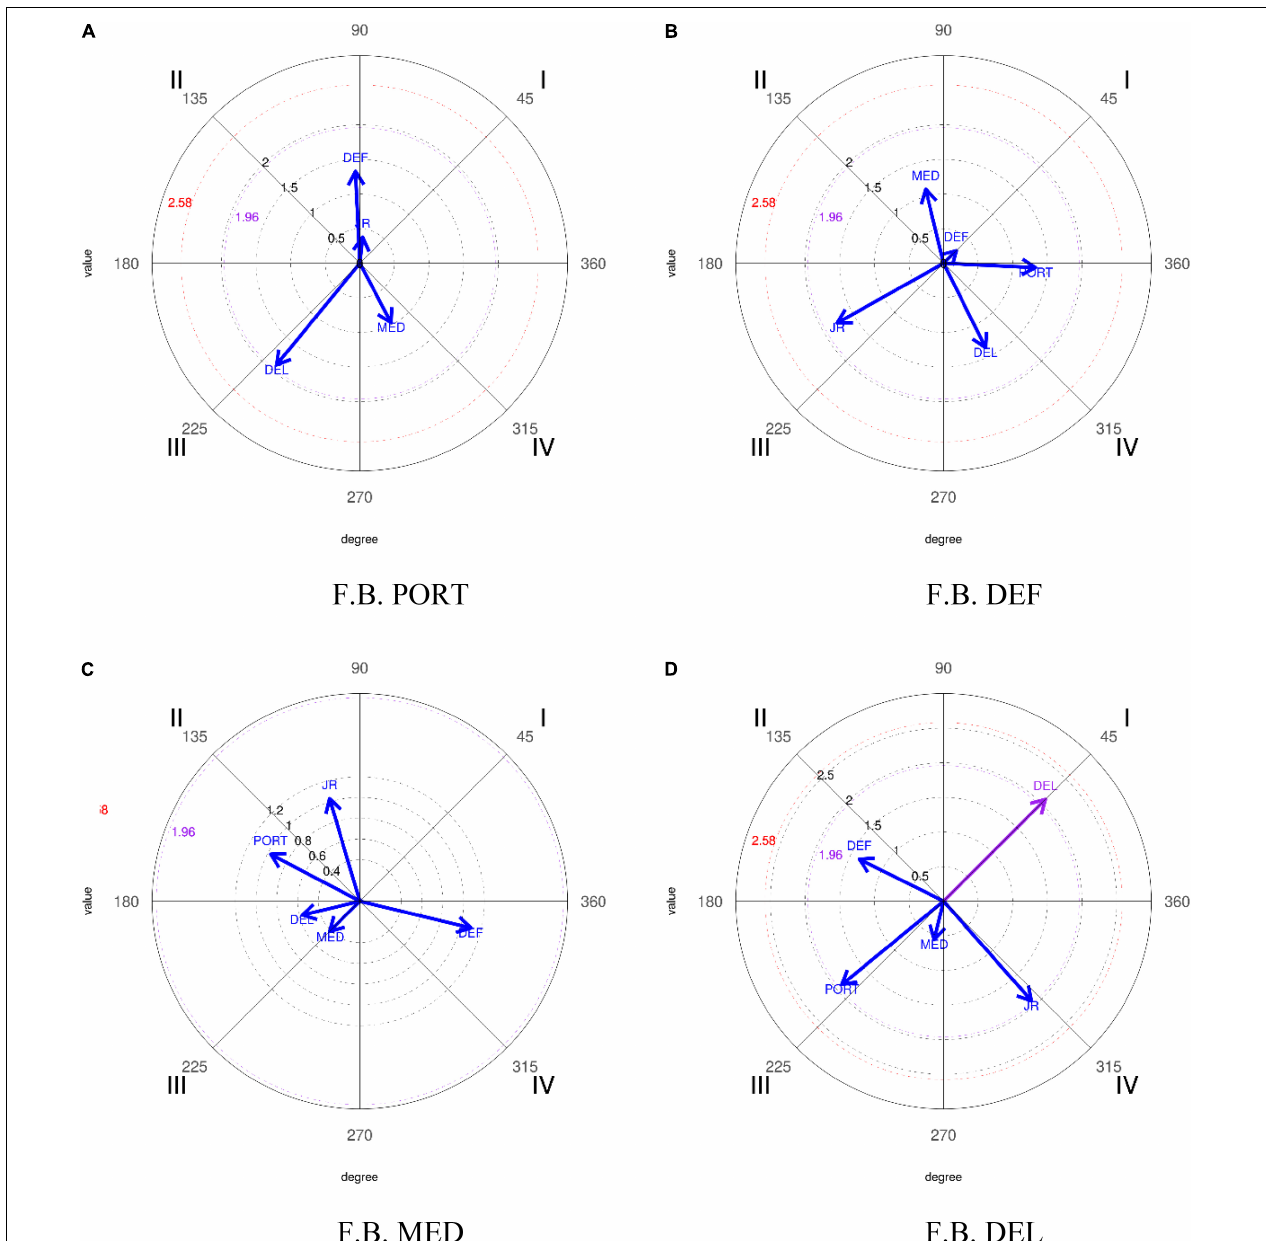
FIGURE 4 | Representation of the behavioral maps establishing the different categories as focal behavior, in relation to the lines that structure the team for the 2017–2018 season. *FB, focal